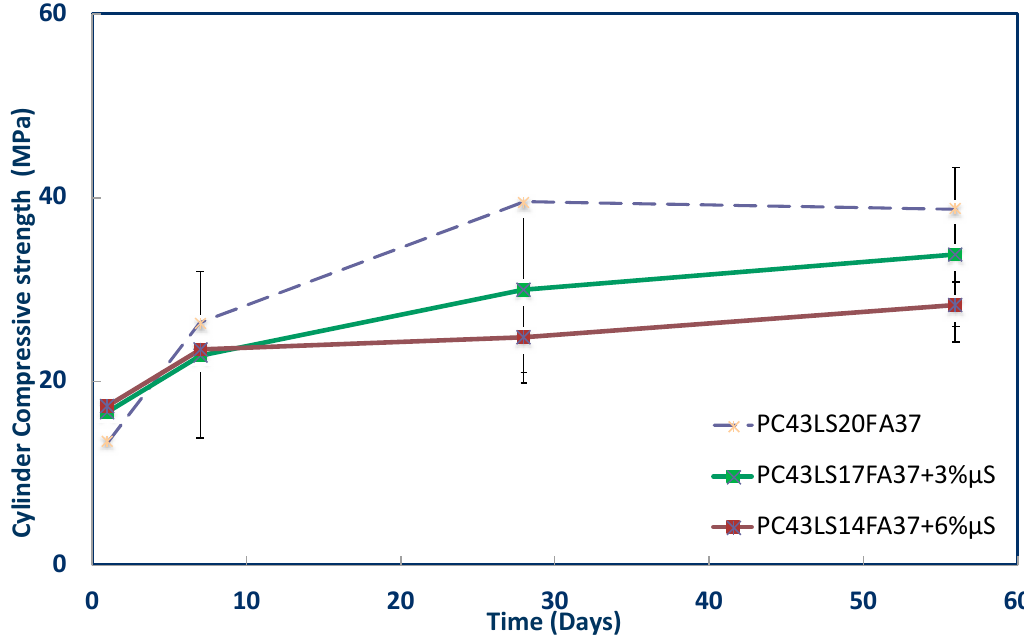
Figure 18. Cylinder compressive strength of µ S modified cement pastes based on PC43LS20FA37.